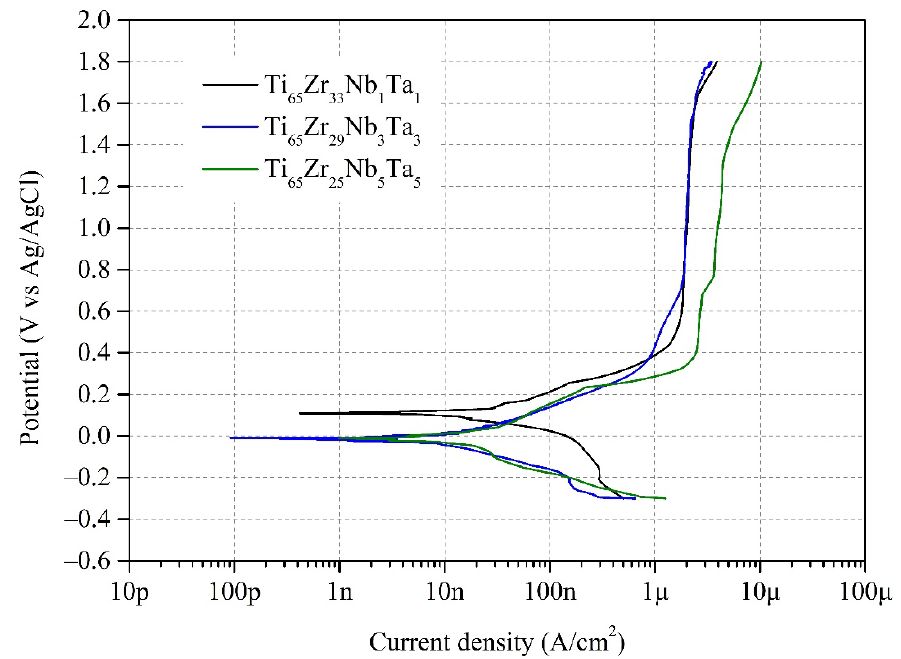
Figure 10. Polarization curves, obtained using potentiodynamic polarization tests, of Ti 65 –Zr 33 –Nb 1 –Ta 1 , Ti 65 –Zr 29 –Nb 3 –Ta 3 , and Ti 65 –Zr 25 –Nb 5 –Ta 5 in artificially simulated body fluid (phosphate-buffered saline) at 37 °C.